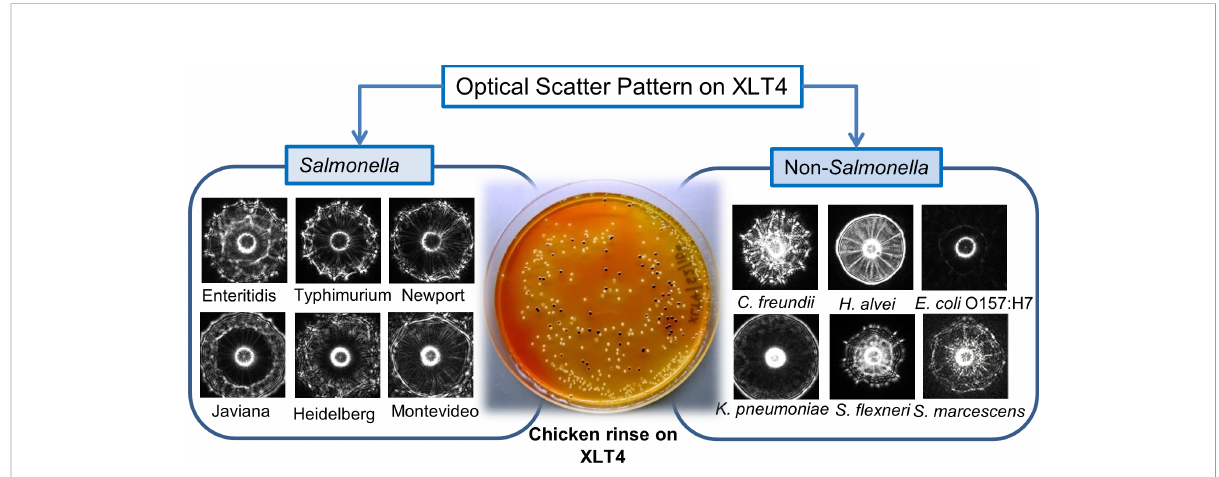
FIGURE 3 Detection and identi fi cation of colonies of Salmonella enterica serovars using BARDOT in the presence of background non- Salmonella bacteria on Salmonella selective XLT4 agar plate. Source (Singh et al.,